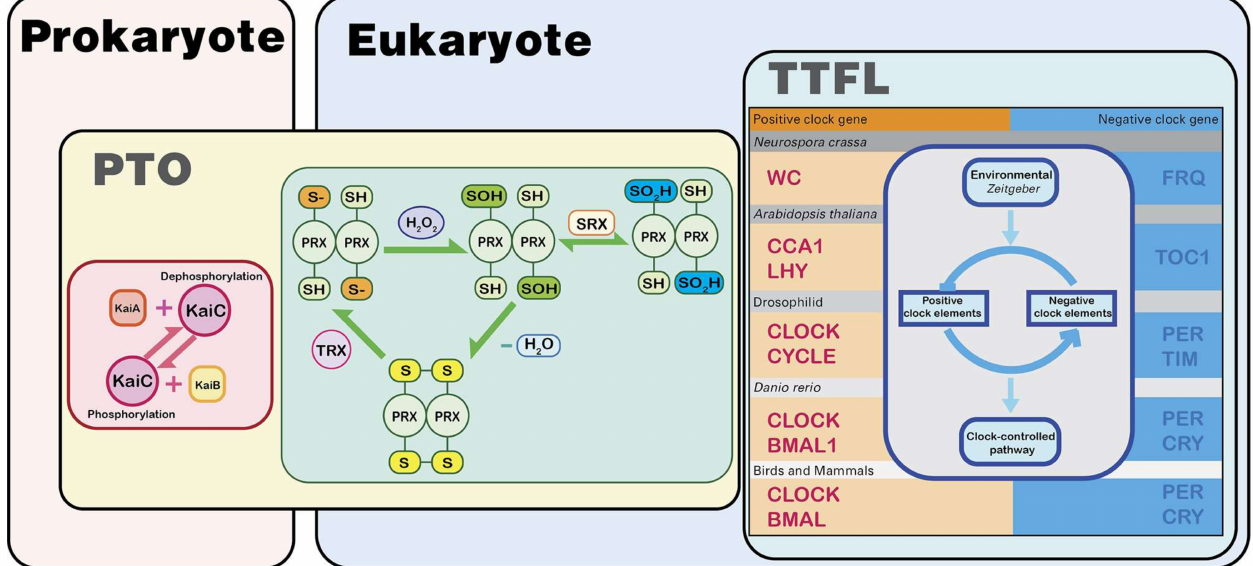
Figure 2. The biological clock in prokaryotes is mainly based on the post-translational oscillation mechanism (PTO). The most typical one is the oscillator with KaiA/B/C as the core, found in cyanobacteria. This oscillator relies on the autokinase and autophosphatase activities of the core protein KaiC for experiments. In eukaryotes, the transcription–translation negative feedback loop (TTFL) mechanism is the main oscillation mechanism of the biological clock. Their molecular composition is different in different organisms, but they have the same principle. There is a biological clock oscillator with the PTO mechanism in eukaryotes. The “redox” oscillator with the PRX protein as the core is widely present in eukaryotes and has a strong correlation with prokaryotic oscillators. The PRX oscillator may be the key to connect the eukaryotic–prokaryotic oscillator and may also be the oldest origin of the biological clock. Zeitgeber : an environmental agent (the occurrence of light or dark) that provides the stimulus setting a biological